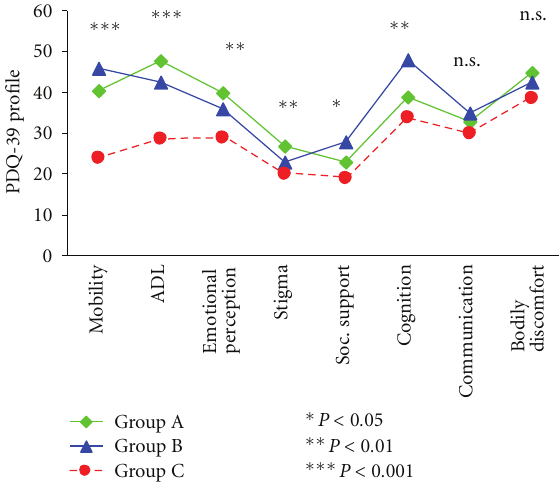
Figure 3: PD-patients of group C reported less PD-specific impair- ment at the final assessment. The y -axis shows the percentage of the maximal possible sum scores. The x -axis shows the 8 subscales of the PDQ-39. The lines represent the scores the groups have achieved in the 8